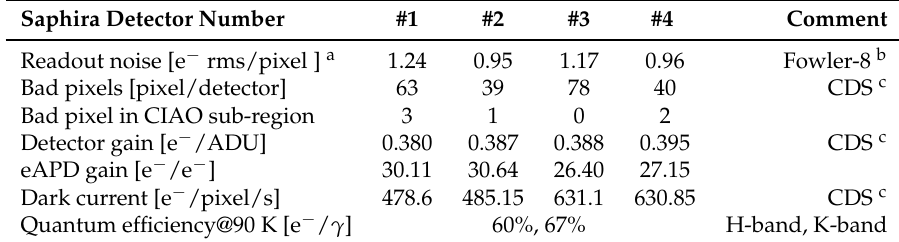
Table 2. CIAO Saphira detector characteristics @ 95 K temperature, or as indicated Saphira Detector Number